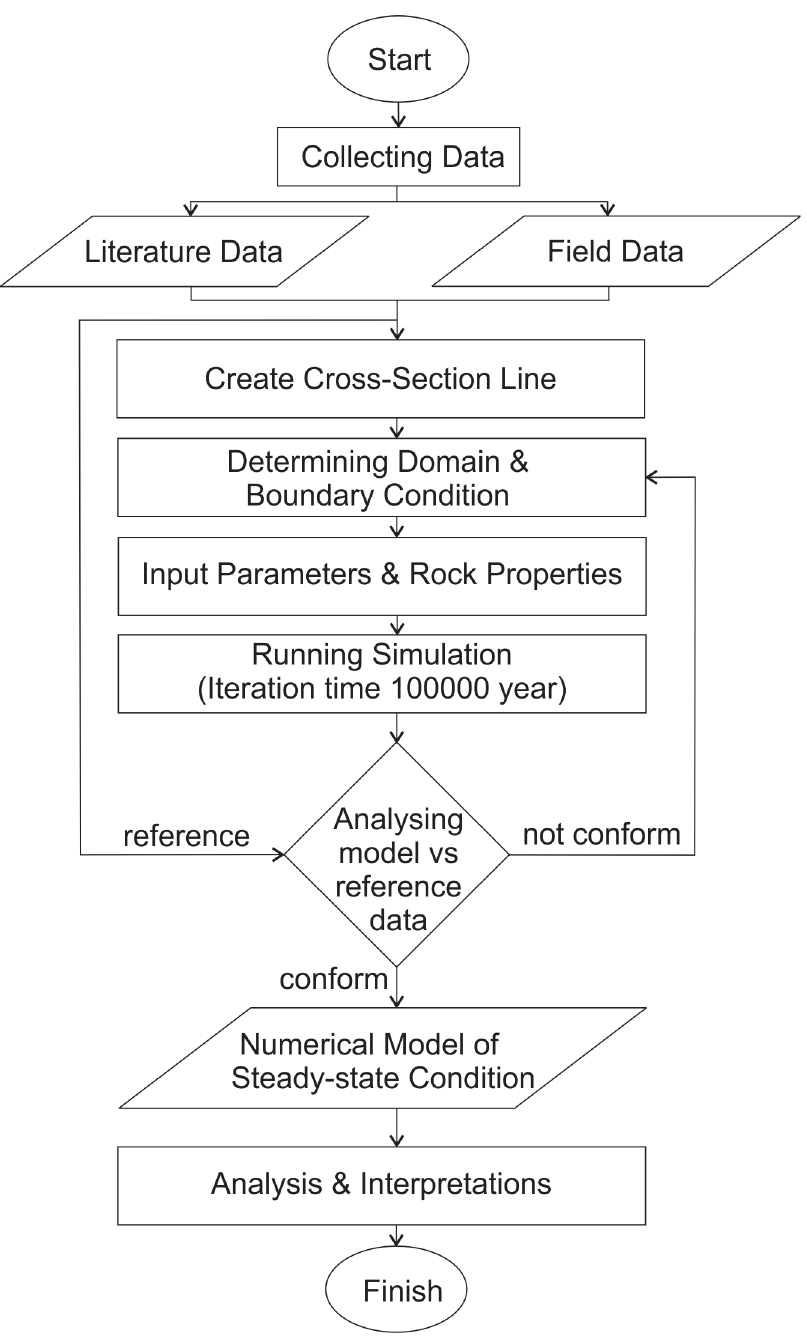
Fig. 4. Flowchart showing step of processing activities and numerical